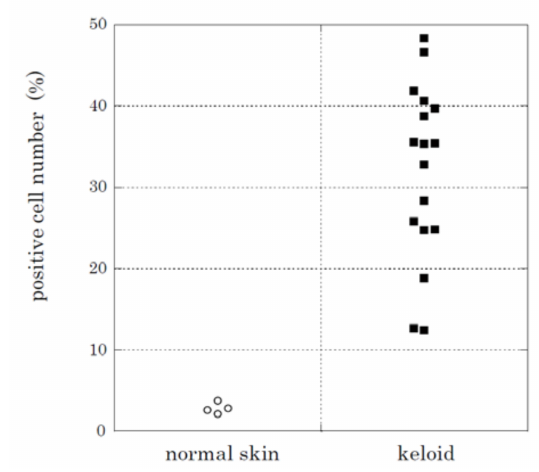
Figure 5. Proportion of fibroblasts expressing HtrA1 protein in keloid lesions and normal skin. The number of fibroblasts with positive signals was counted after immunohistochemical staining of HtrA1 using samples from 17 keloidand 4 unrelated patients. Ten high-power ( × 400) fields were selected at random from a section and numbers of total and stained fibroblasts were counted. Patient information is described with proportion of HtrA1-positive cells in Table